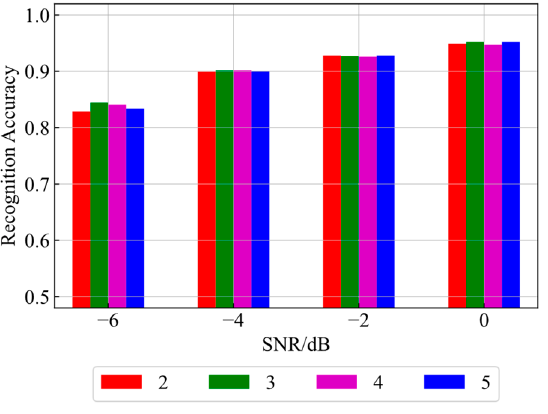
Figure 8. Comparison of recognition accuracy with different feature dimensions.